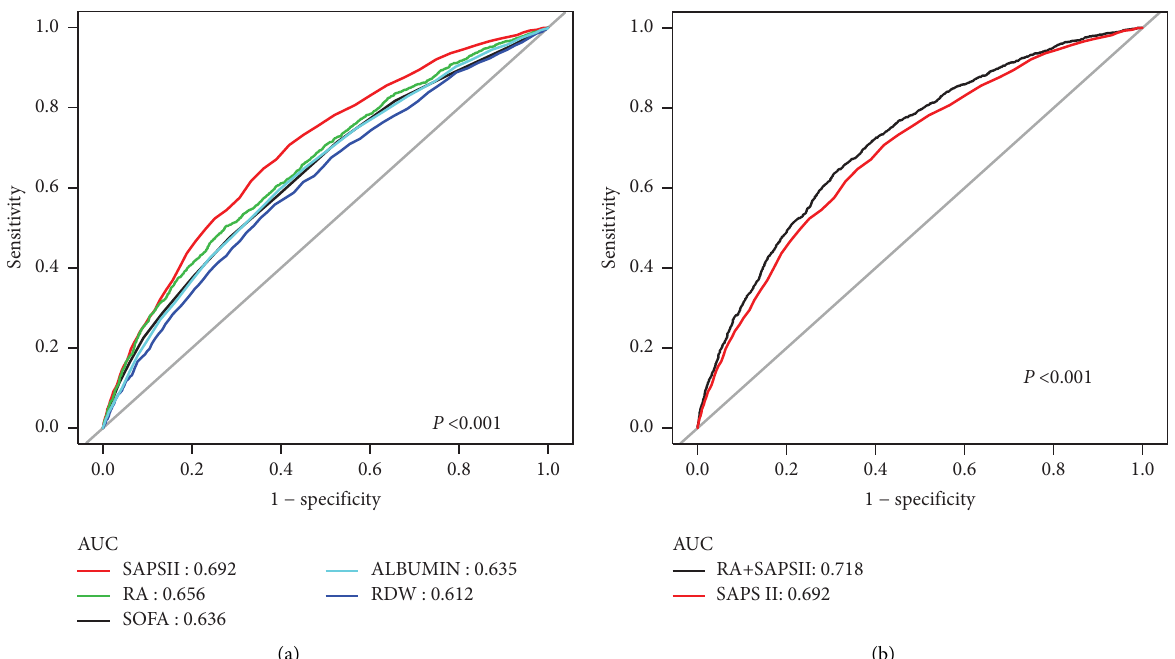
Figure 2: ROC curves for the prediction of 90-day all-cause mortality in critically ill patients with AKI.